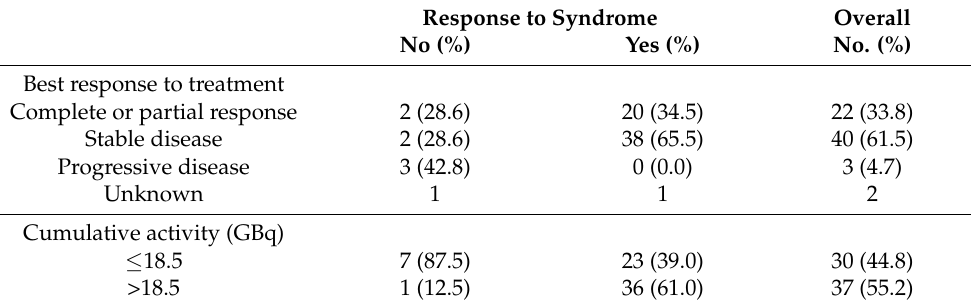
Table 3. Relation between best response to treatment and response to